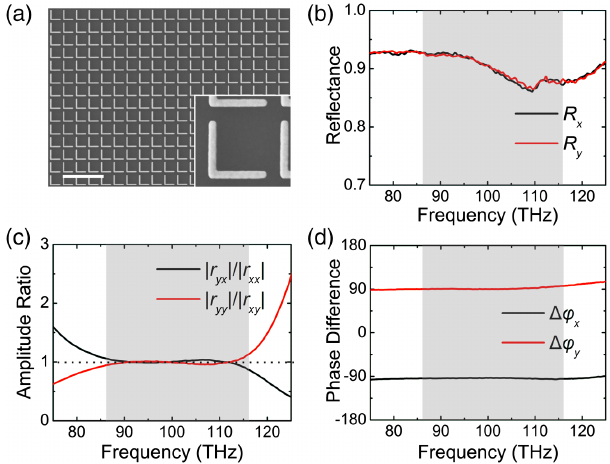
FIG. 2. (a) Field-emission scanning electron micrograph of the array of gold L patterns fabricated by electron beam lithography. The bar represents 5 μ m. (b) Experimentally measured reflec- tance for the x - and y -polarized incident light. (c),(d) Experi- mentally measured amplitude ratio and phase difference of the sample under the illumination of x - and y -polarized light,